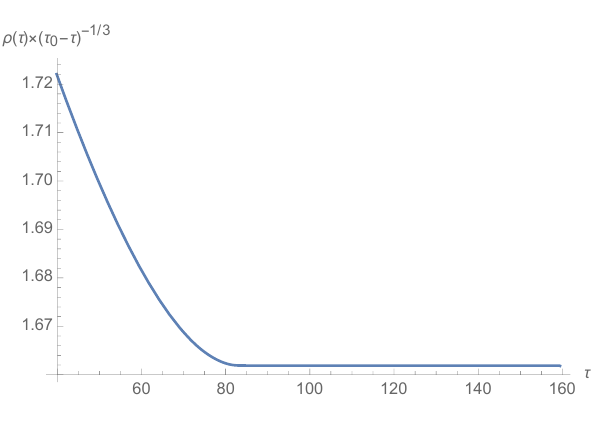
Figure 2 . φ crosses the barrier.